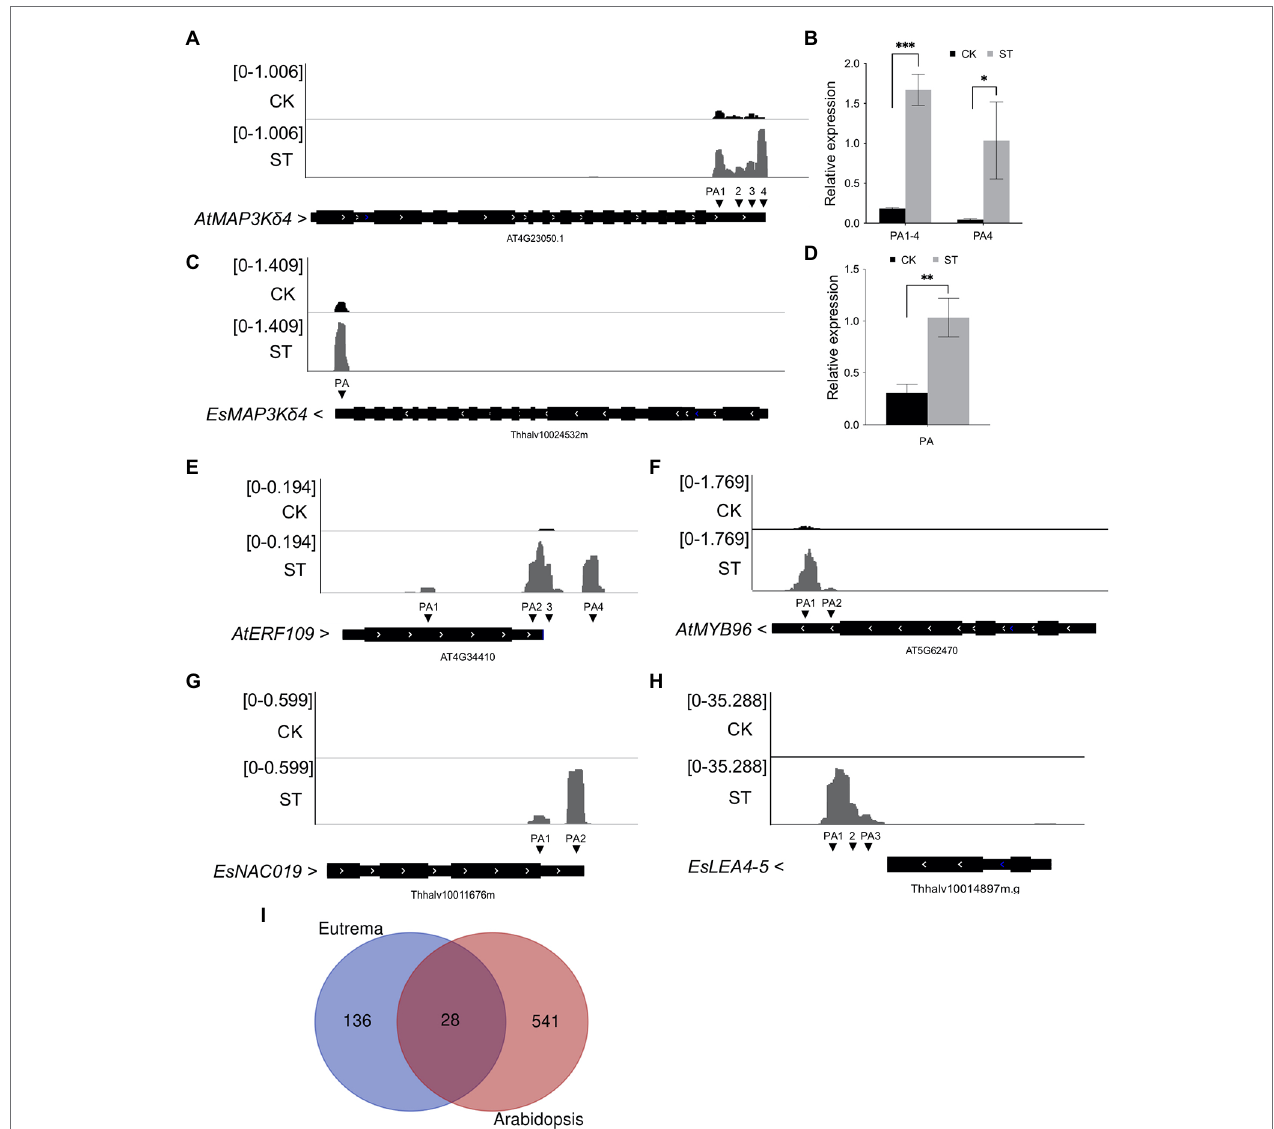
FIGURE 6 | Differential APA in genes related to salt tolerance in Arabidopsis and Eutrema . (A) Integrative Genomics Viewer (IGV) showing the poly(A) sites of AtMAP3K δ 4 ( AT4G23050 ). CK, control; ST, salt stress. PA represents poly(A) site. Arrows beside gene names indicate gene orientation. (B) RT-qPCR was used to determine the expressive levels of distal poly(A) sites in AtMAP3K δ 4 . (C) IGV showing the poly(A) site of EsMAP3K δ 4 ( Thhalv10024532m ). (D) RT-qPCR was used to determine the expressive level of EsMAP3K δ 4 . (E) IGV showing the poly(A) sites of AtERF109 ( AT4G34410 ). (F) IGV showing the poly(A) sites of AtMYB96 ( AT5G62470 ). (G) IGV showing the poly(A) sites of EsNAC019 ( Thhalv10011676m ). (H) IGV showing the poly(A) sites of EsLEA4-5 ( Thhalv10014897m ). (I) Venn plot showing the overlap of salt-specific PAC genes in Arabidopsis and Eutrema . Numbers indicate gene numbers. Statistical significance was determined by one-way ANOVA, * p < 0.05, ** p < 0.01, and *** p <